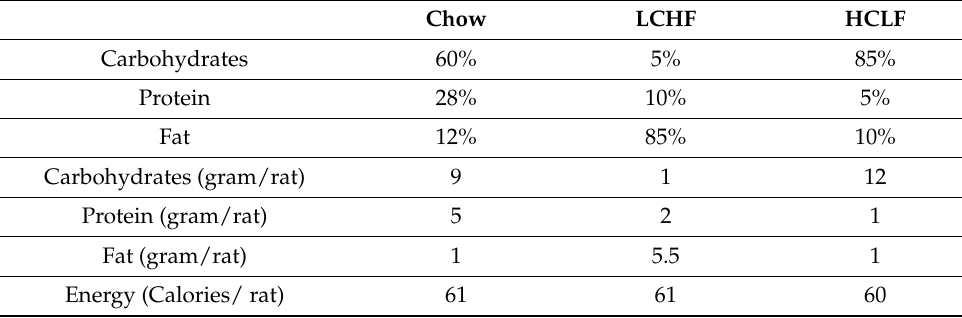
Table 1. The composition of Chow, LCHF, and HCLF